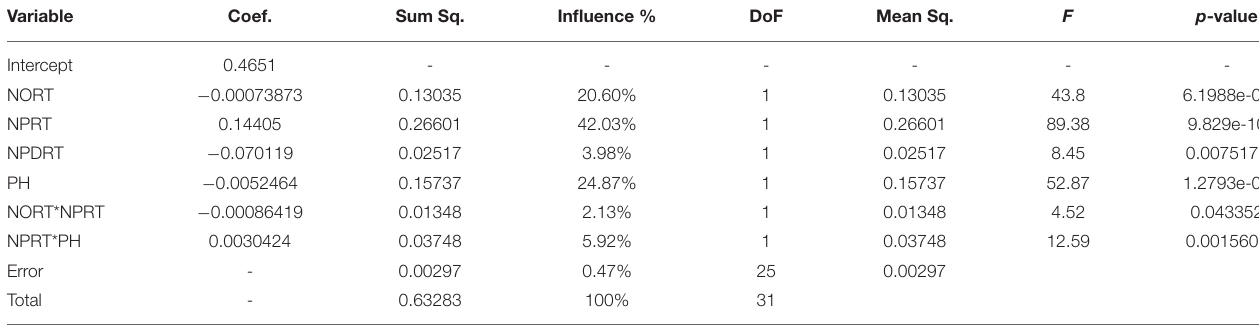
TABLE 3 | ANOVA table of the reduced